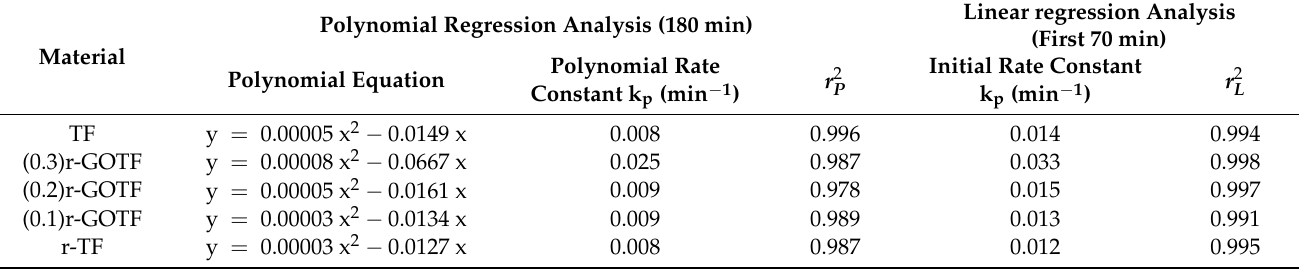
Table 6. Linear and polynomial kinetic parameters for visible light